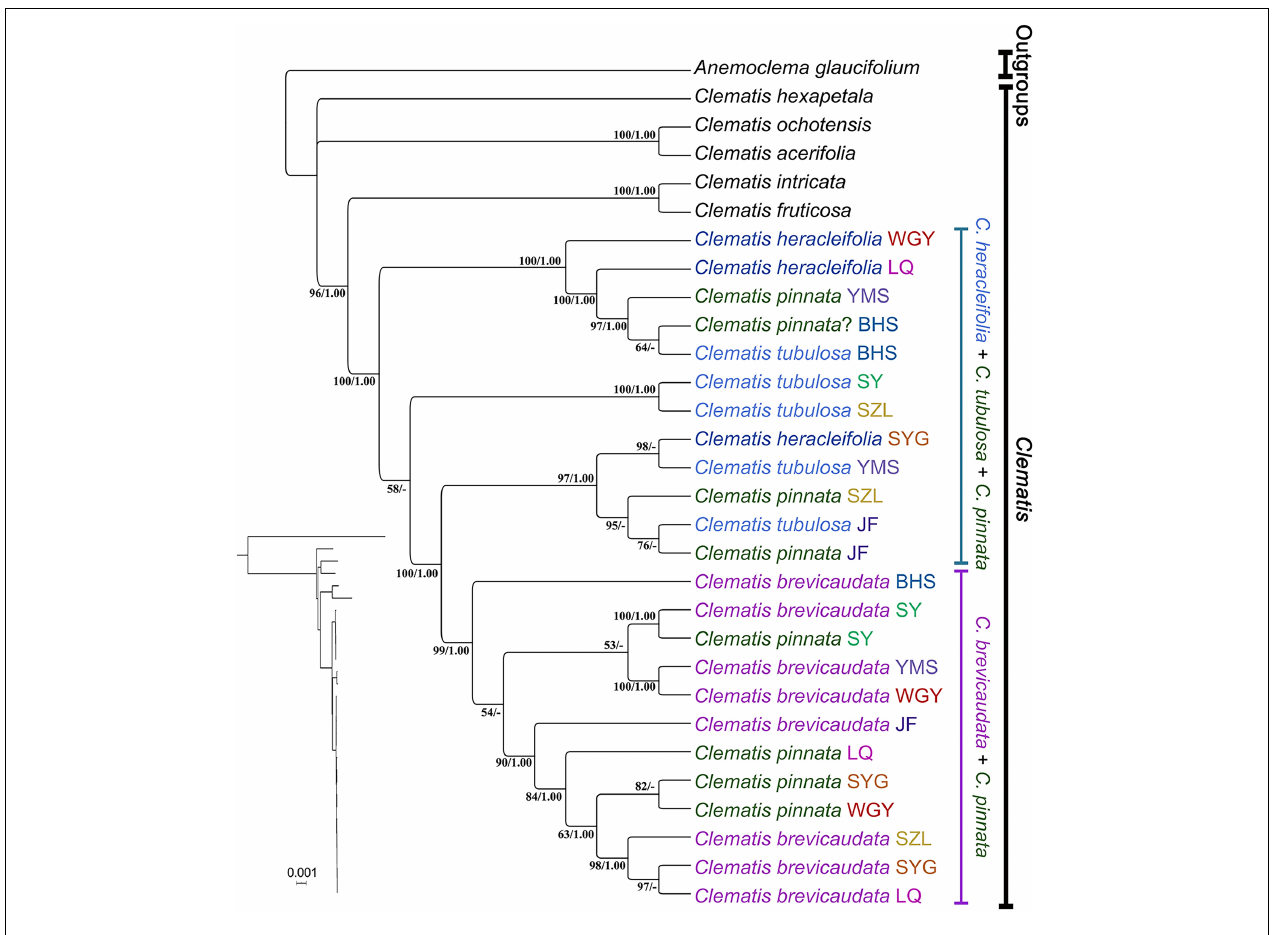
FIGURE 5 | Phylogeny of eight populations (one individual for each population) of Clematis pinnata and its close relatives inferred from complete plastome sequences using maximum likelihood and Bayesian inference methods. Bayesian phylogram is shown left below and the dendrogram with ML bootstrap values/posterior probability values are shown at right side. Population location name abbreviations are explained in Table 2 . – shows that support values of ML bootstrap values are less than 50 and Bayesian PP values are less than